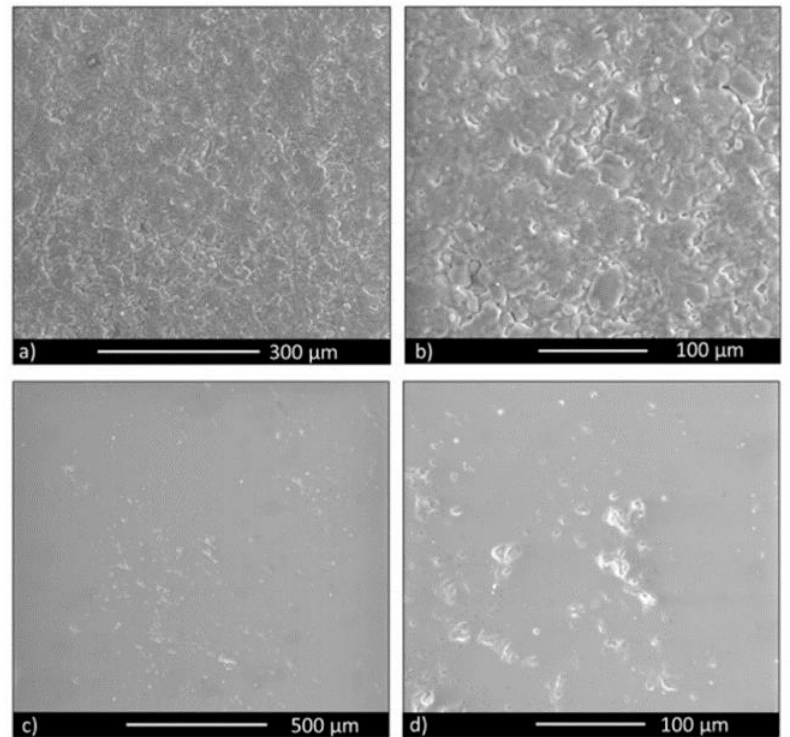
Figure 1. Scanning electron microscopy (SEM) observation of the BGMS10 disk surface: unpolished — low magnification ( a ); unpolished — high magnification ( b ); polished — low magnification ( c ); polished — high magnification ( d ).